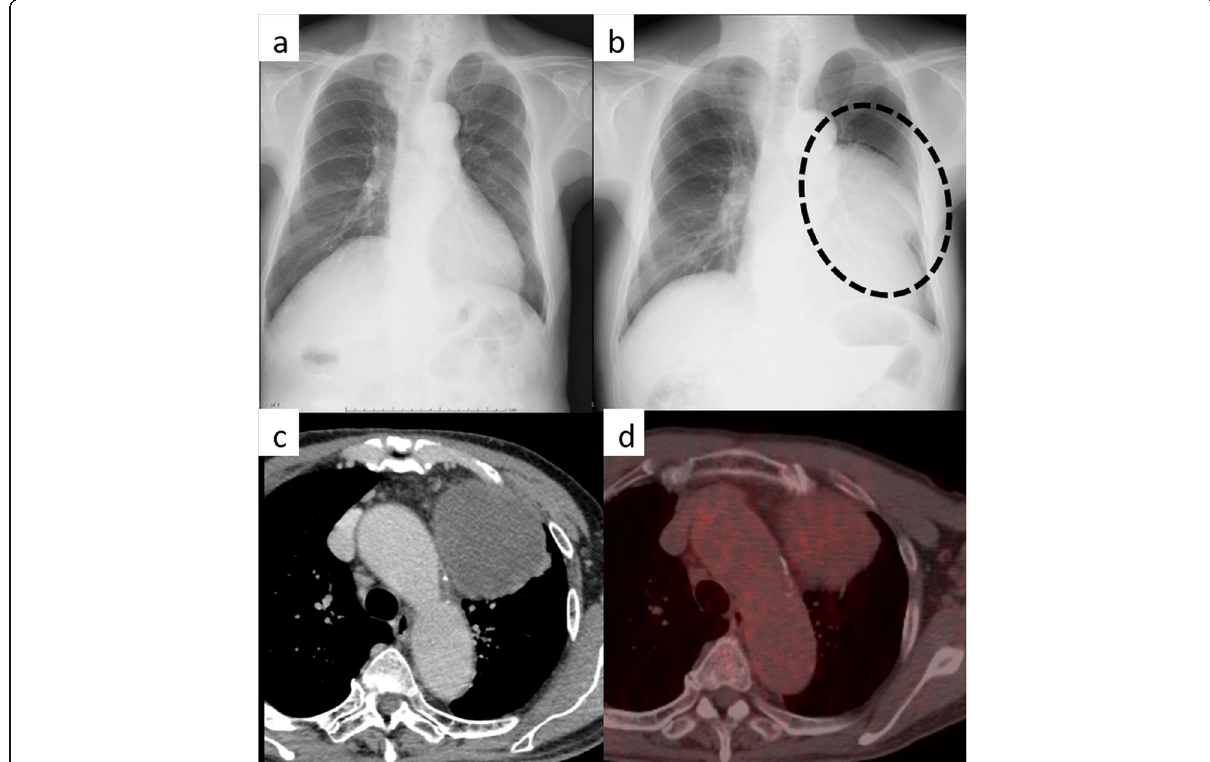
Fig. 1 Chest radiography showing the mass ( b : dotted circle). The mass was not observed a year ago ( a ). Chest-enhanced computed tomography showing an approximately 11-cm mediastinal tumor occupying left internal cavity ( c ). Fluorodeoxyglucose-positron emission tomography showing accumulation in the tumor (maximum standard uptake value = 3.3) ( d